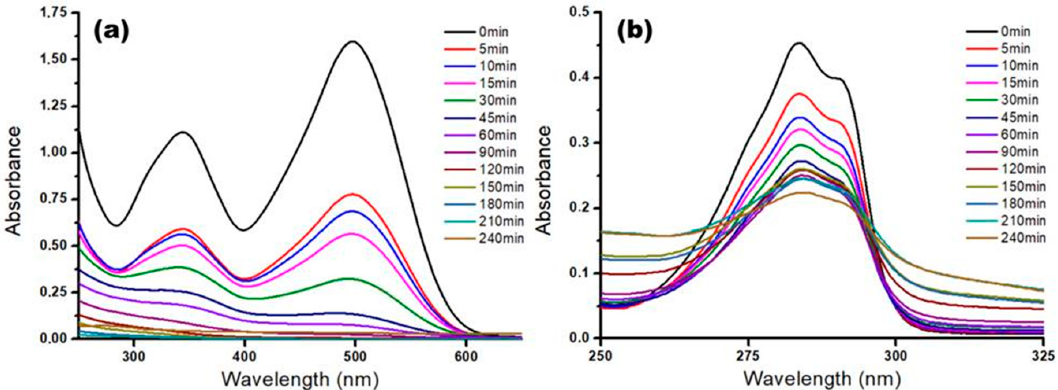
Figure 7. UV–Vis spectra profiles at various irradiation times accounting for the photodegradation reactions in the presence of the catalyst sample M5 (dosage = 0.167 g/L); ( a ) photodegradation of CR dye (50 mg L − 1 ); ( b ) photodegradation of 2,4-D herbicide (50 mg L − 1 ).